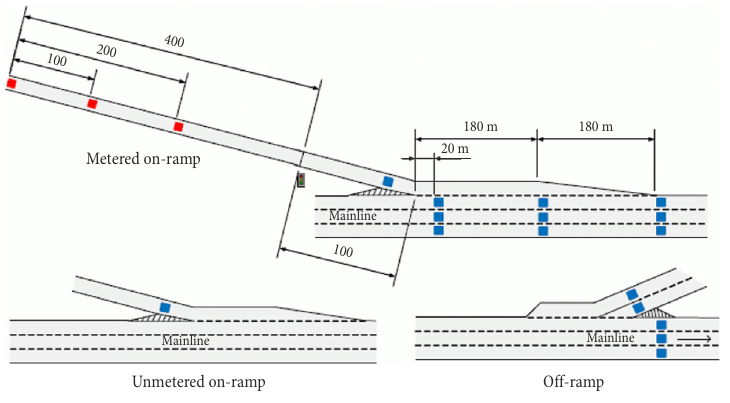
Fig. 3. The scheme for adaptive control access to the highway